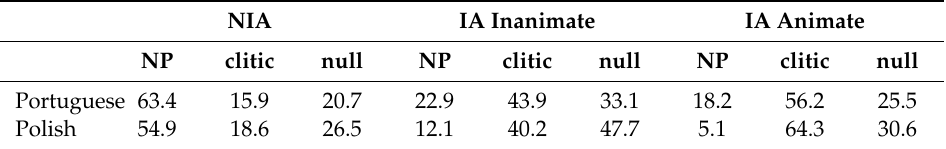
Table 4. Distribution of object forms per condition and per group (in %). NIA IA Inanimate IA